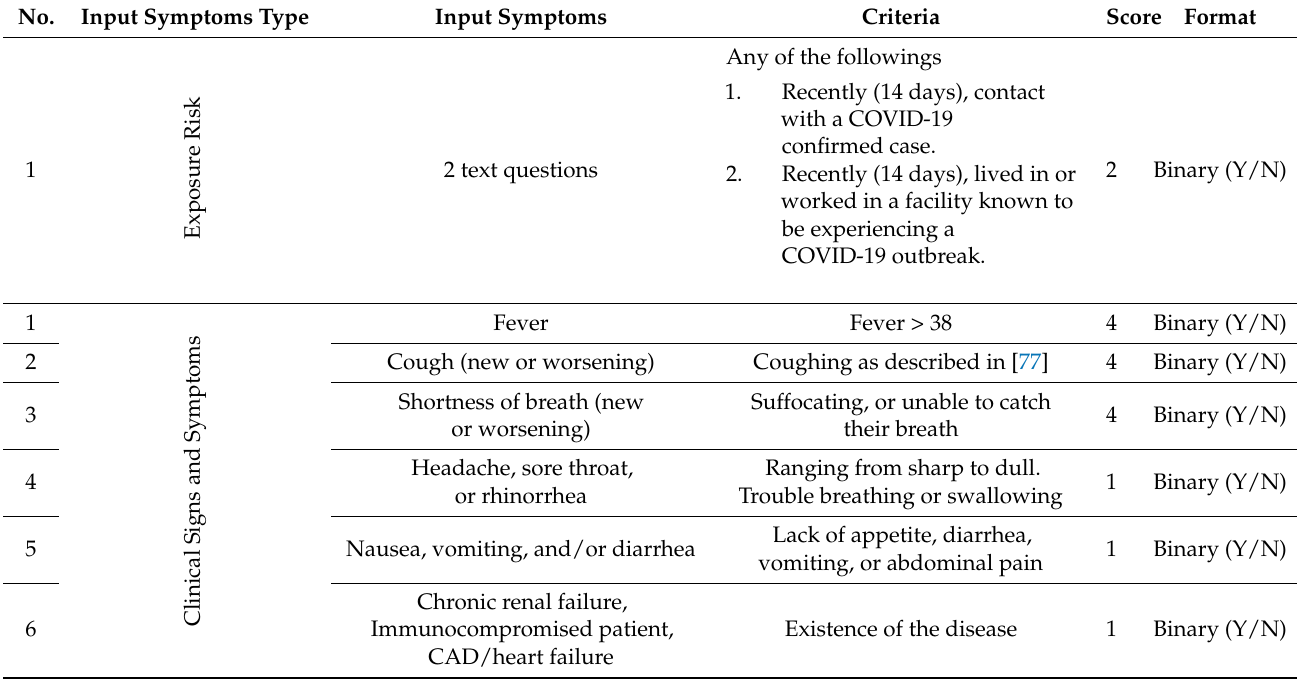
Table 9. Recommended admission scored-based criteria for